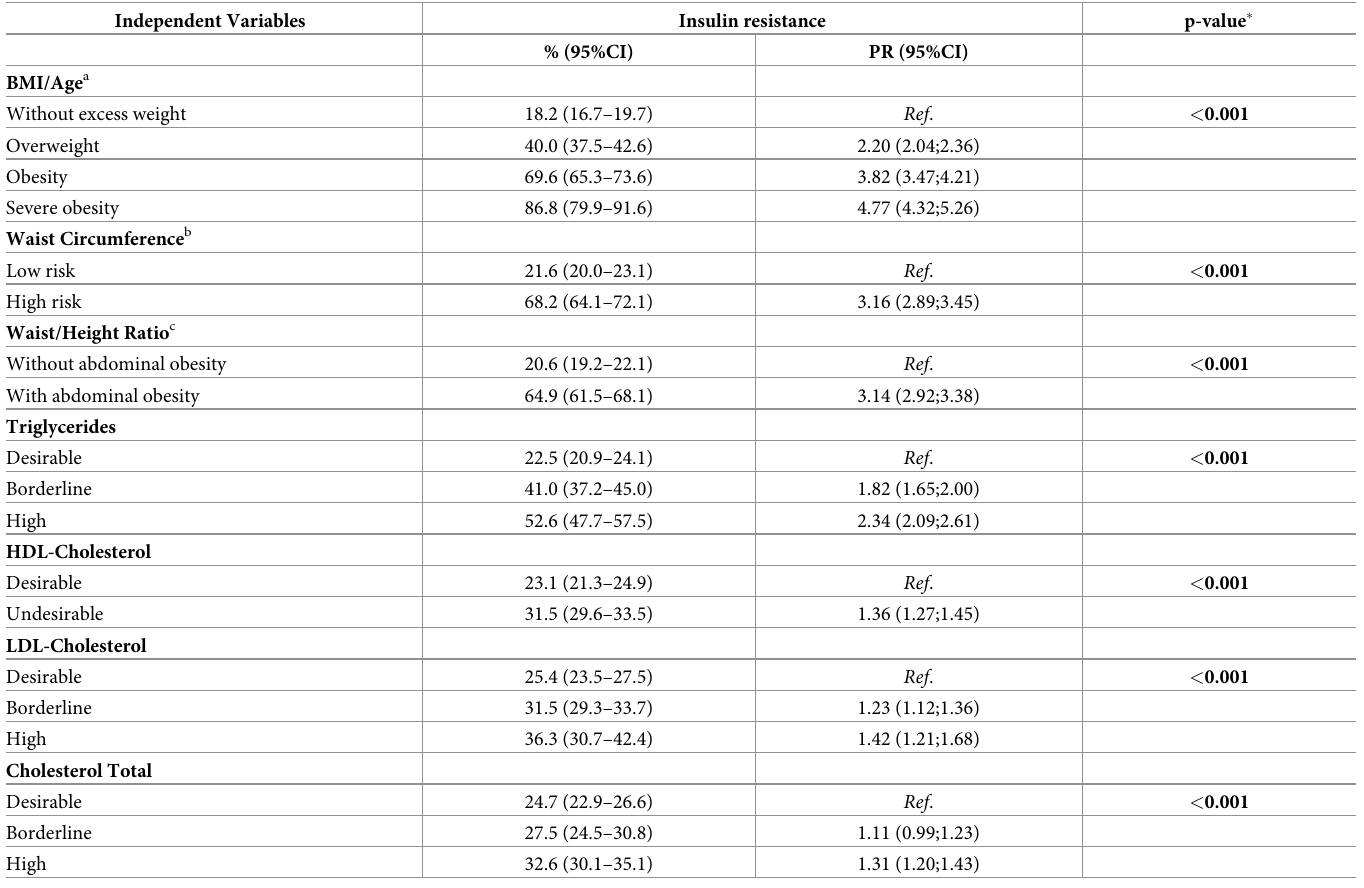
Table 6. Prevalence of insulin resistance, prevalence ratios, and confidence intervals according to anthropometric and biochemical characteristics of Brazilian ado- lescent students. ERICA Study, 2013–2014. Independent